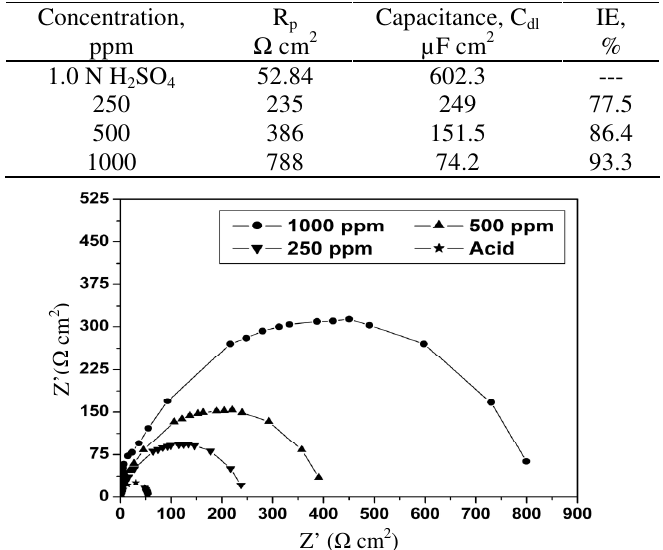
Table 3. Impedance parameters obtained using electrochemical impedance method in 1 N H SO at 303 K 2 4